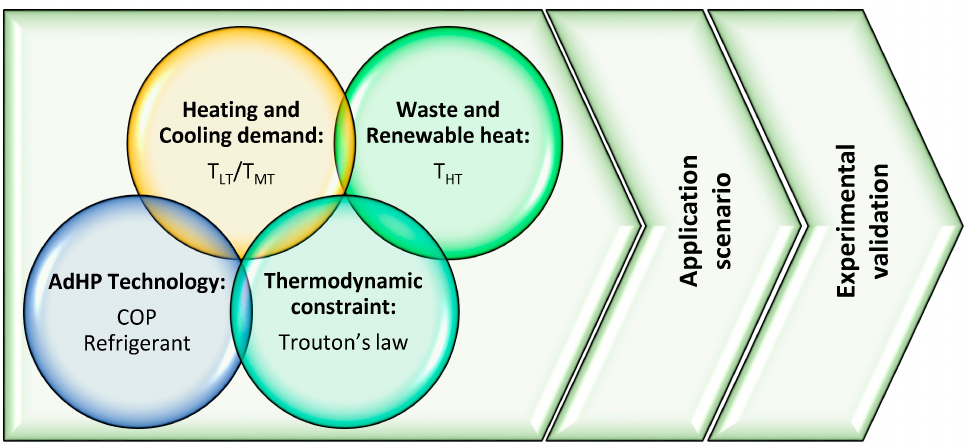
Figure 1. Diagram of the methodological framework for the elaboration and validation of the application scenarios of the adsorption heat pump (adHP).